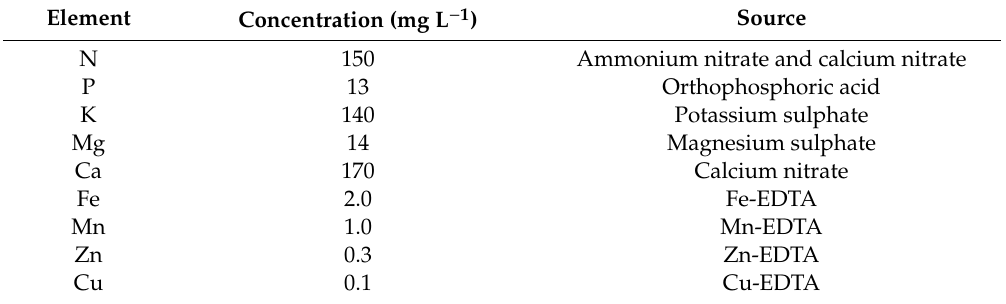
Table 2. Nutrients concentration and fertilizers used for preparing the nutrient solution used for fertigation of olive orchard in Lamezia Terme used for the experiment in the year